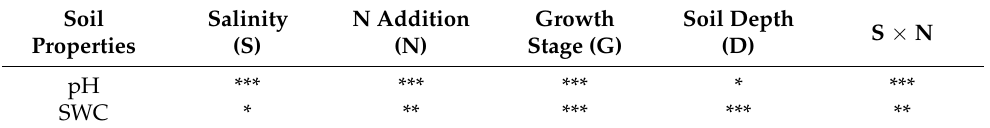
Table 2. Results of multiple-way ANOVA on the effects of salinity (S), N addition (N), growth stage (G), and soil depth (D) and their interactions on soil pH and water contents.